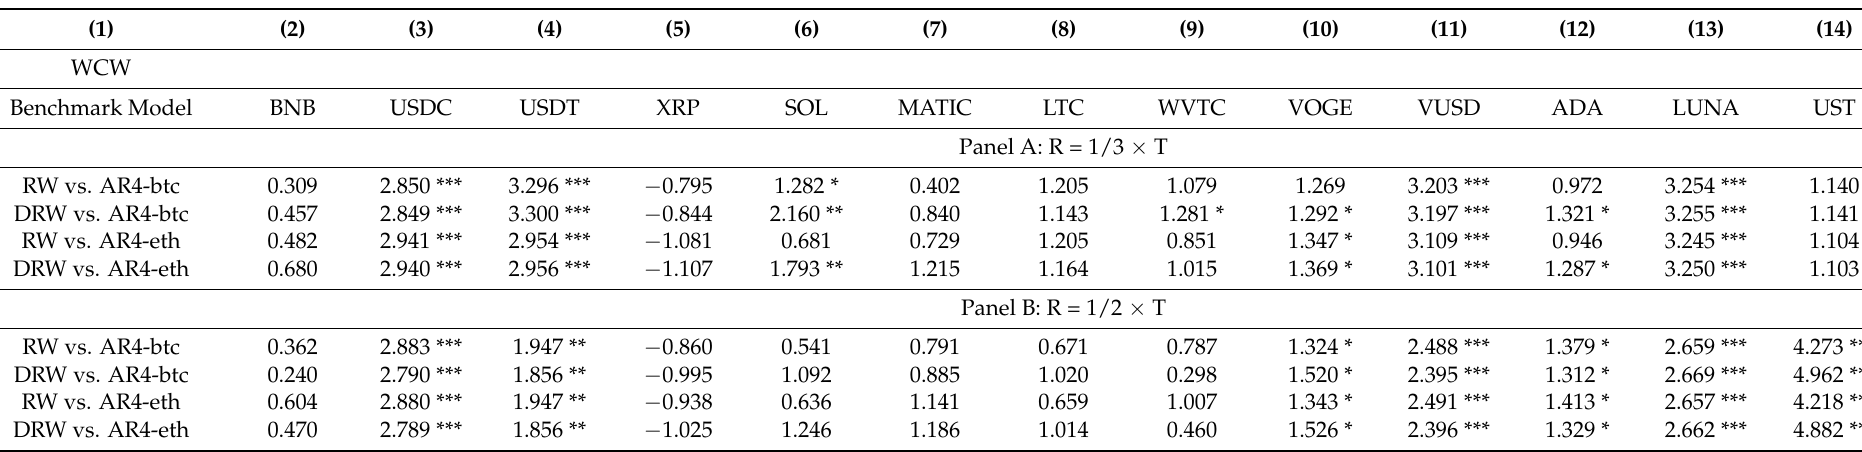
Table 5. The out-of-sample results using the Wild Clark and West test for different benchmarks and estimation windows.